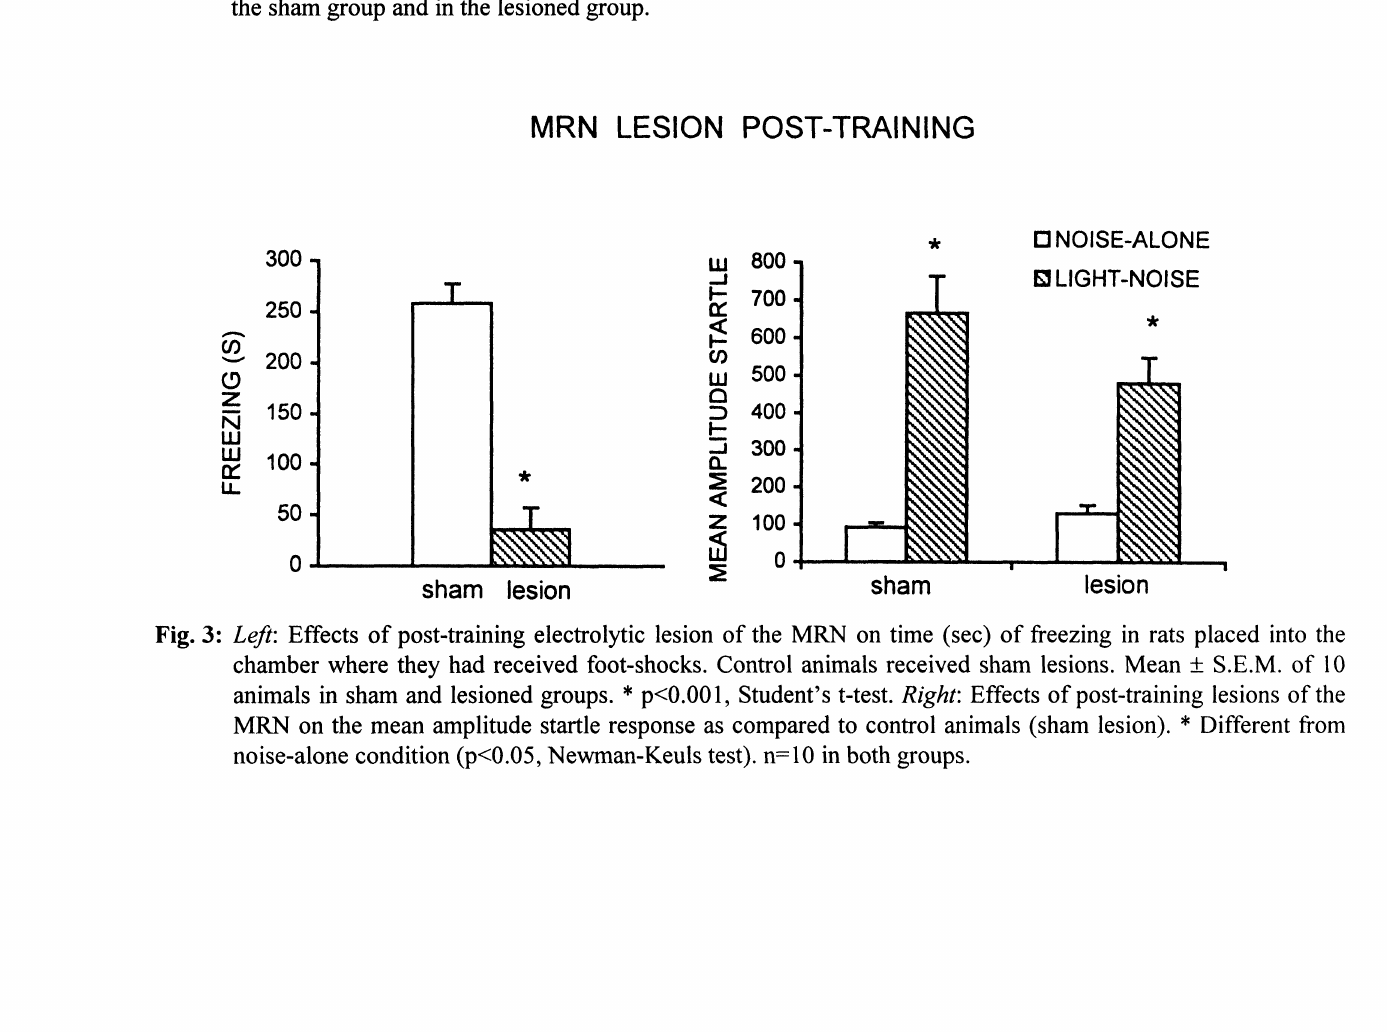
Fig. 2: Left: Effects of pre-training electrolytic lesion of the MRN on time (sec) of freezing in rats placed into the chamber where they had received footshock. Control animals received sham lesions. Mean + S.E.M. of 10 animals in sham and lesioned groups. *p<0.01, Student’ t-test. Right: Effects of pre-training lesions of the MRN on the mean amplitude startle response as compared to control animals (sham lesion). * Different from noise-alone condition, and # different from the respective control group (p<0.05, Newman-Keuls test), n 10 in the sham group and in the lesioned group.